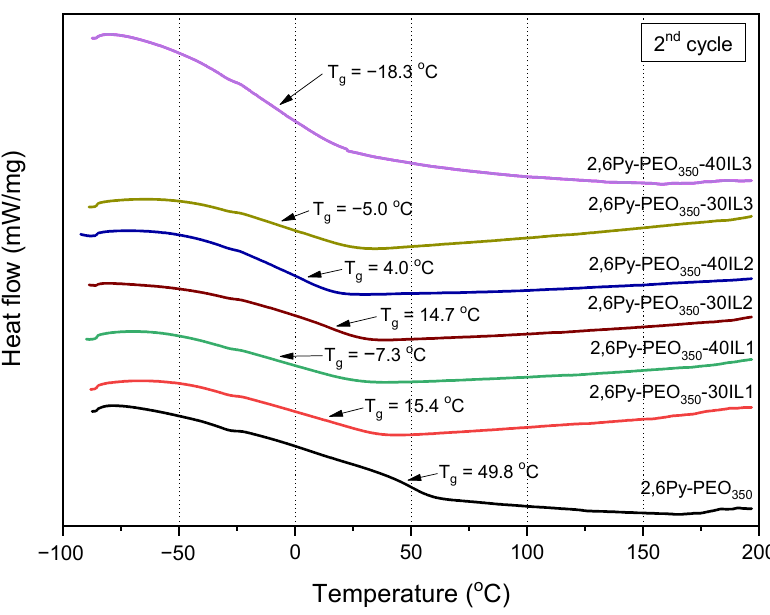
Figure 4. DSC curves for the precursor polymer and the polymer-IL composite membranes. The membrane morphology plays a vital role in gas separation and purification per- formance. The cross-sectional SEM micrographs of polymer-IL composite membranes containing 40 wt% of each IL are illustrated in Figure 5. It was revealed that all membranes are dense, smooth and not phase-separated. This suggests that ILs were uniformly dis- tributed into the polymer matrix, leading to non-porous, homogeneous structures. Similar observations were reported for the Pebax ® 1657/(Emim]BF 4 ]) polymer IL pair by Rabiee et al. [18]. The thickness of the membranes ranges from 47 to 165 μ m.